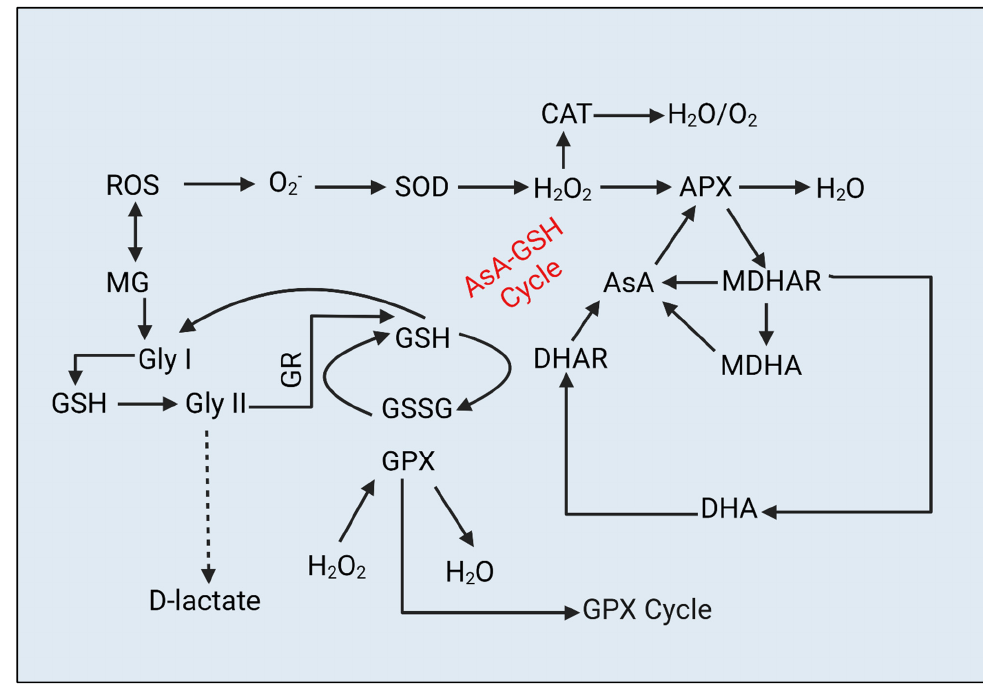
Figure 7. Schematic representation of the involvement of the ascorbate–glutathione (AsA–GSH) and Glyoxalase cycles in response to excessive reactive species (ROS and RCS) production under drought stress in L. fusca plants. The AsA–GSH cycle is typically involved in ROS scavenging, while the Glyoxalase cycle deals with MG detoxi fi cation in plants under stress. This fi gure was prepared by using Biorender so ft ware.